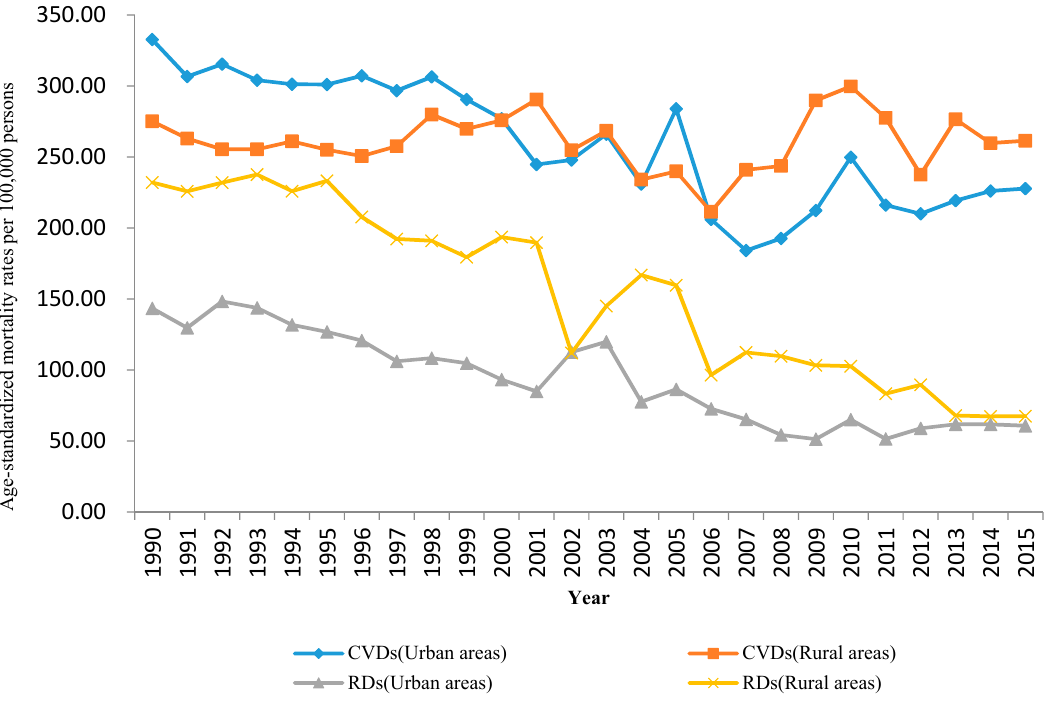
Figure 1. The trend on the age-standardized mortality rates of CVDs and RDs in urban and rural areas during 1990 to 2015.